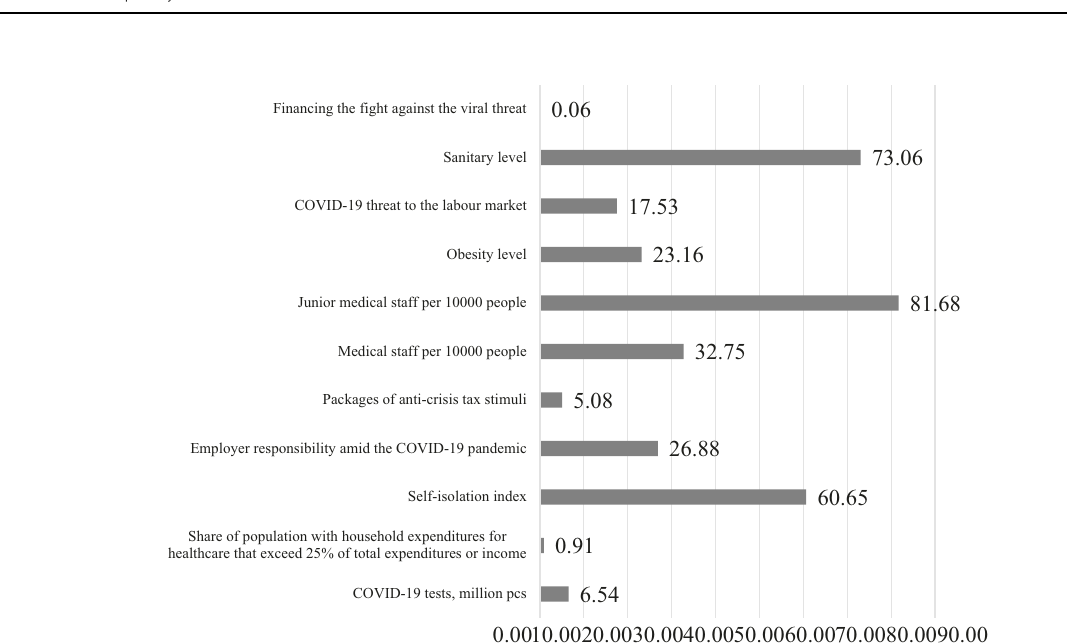
Fig. 5 Characteristics of social drama amid the unfolding pandemic and the direction of change management at the governmental level in 2020. Source : Calculated and compiled by the